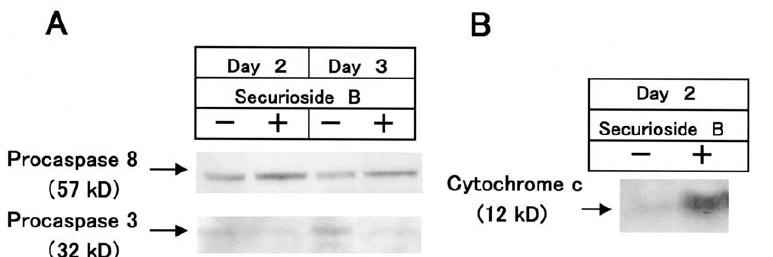
FIG. 6. Western blotting analysis of the processing of procaspases and cytosolic cytochrome c. The BAC1.2F5 cells were harvested on the indicated days, and the processing of procaspase-8 and procaspase-3 (A) or cytosolic cytochrome c(B) were